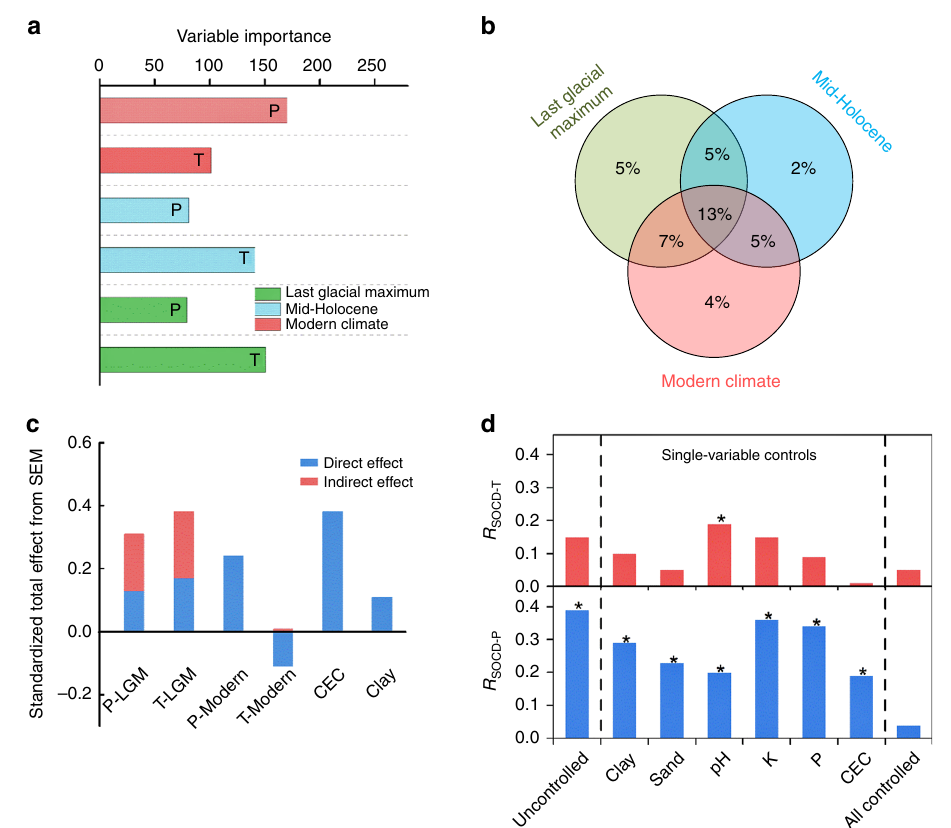
Fig. 2 Relative importance of paleo- and modern climates in regulating soil carbon stock over the permafrost regions of the Tibetan Plateau based on multiple statistical models. The relative importance matrix includes results from: a Random Forest modelling; b Variation Partitioning modelling; c Structural Equation Modelling (SEM). T, the fi rst principle component of all temperature-related variables; P, the fi rst principle component of all precipitation-related variables. d shows the partial correlation coef fi cients between SOCD of the top 30 cm layer and mean annual temperature ( R SOCD-T ) and mean annual precipitation ( R SOCD-P ) in modern times when none of, each of, and all of the soil property variables were controlled (separated by the vertical broken lines). The soil property variables are clay content (Clay), sand content (Sand), soil pH, total potassium (K), total phosphorus (P) and cation exchange capacity (CEC). *Denotes signi fi cant at P <